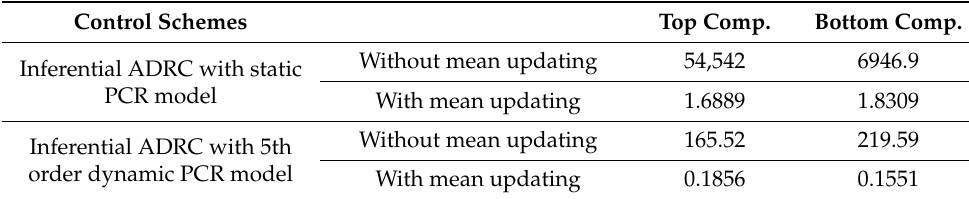
Figure 14. Responses of actual and estimated product compositions under inferential ADRC with order dynamic PCR models (with mean updating). 5th order dynamic PCR models (with mean updating). Table 4. SSE of different control Table 4. SSE of different control schemes.